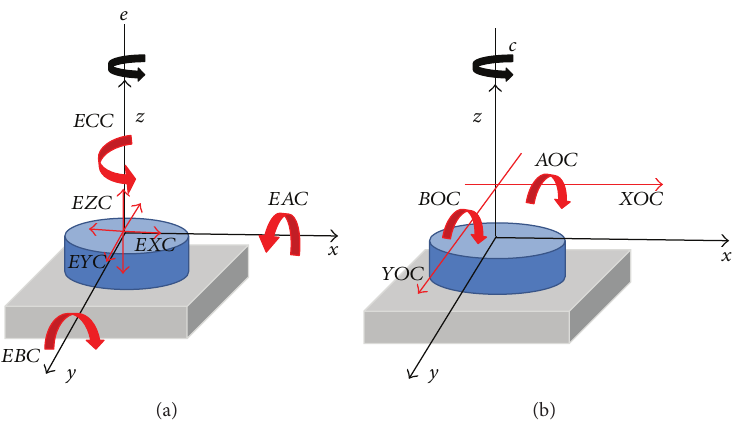
Figure 4: Errors on a rotational axis. Rotational axis 𝑍 .